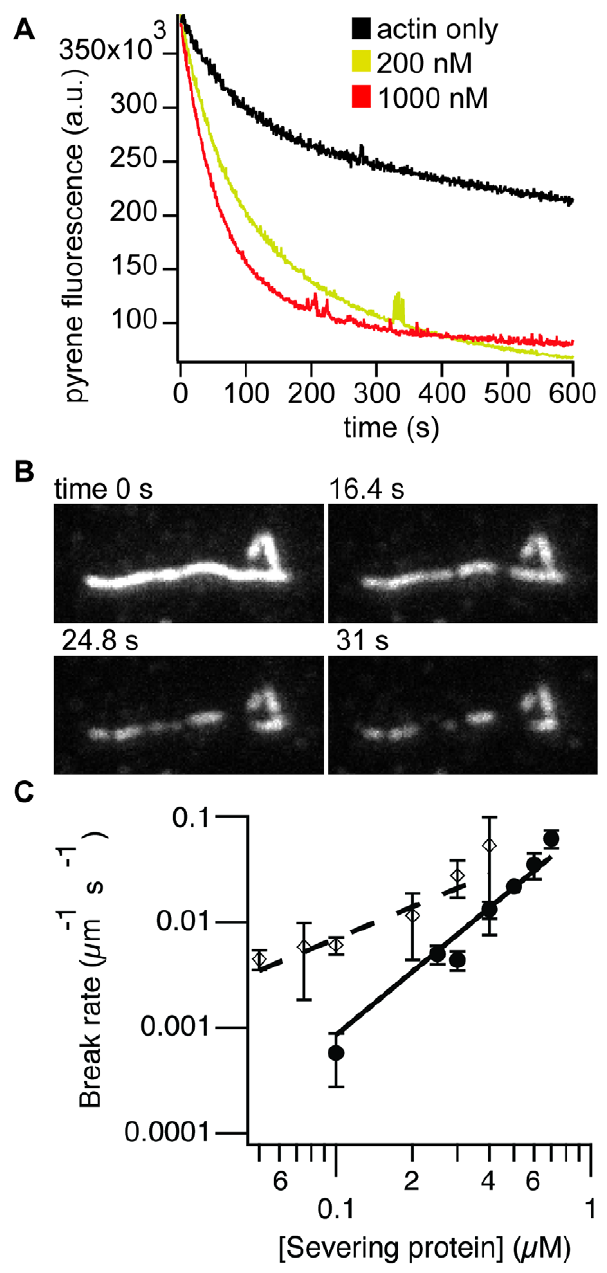
Figure 4. sAB-4 severs actin filaments. (A) Pyrene-actin depoly- merization assay. Filaments are diluted to induce depolymerization. As the sAB-4 concentration increases, the pyrene fluorescence drastically decreases, indicating that sAB-4 enhances depolymerization. (B) TIRF images of an actin filament being severed over time by sAB-4 (0.4 m M). (C) Severing by sAB-4 is a second-order kinetic process. Break rate ( m m actin 2 1 s 2 1 ) of actin filaments over increasing sAB-4 concentration (filled circles). The solid line is a second-power fit to the data (reduced x 2 =3.6). For comparison, first-order severing by gelsolin (open diamonds) is also shown (reduced x 2